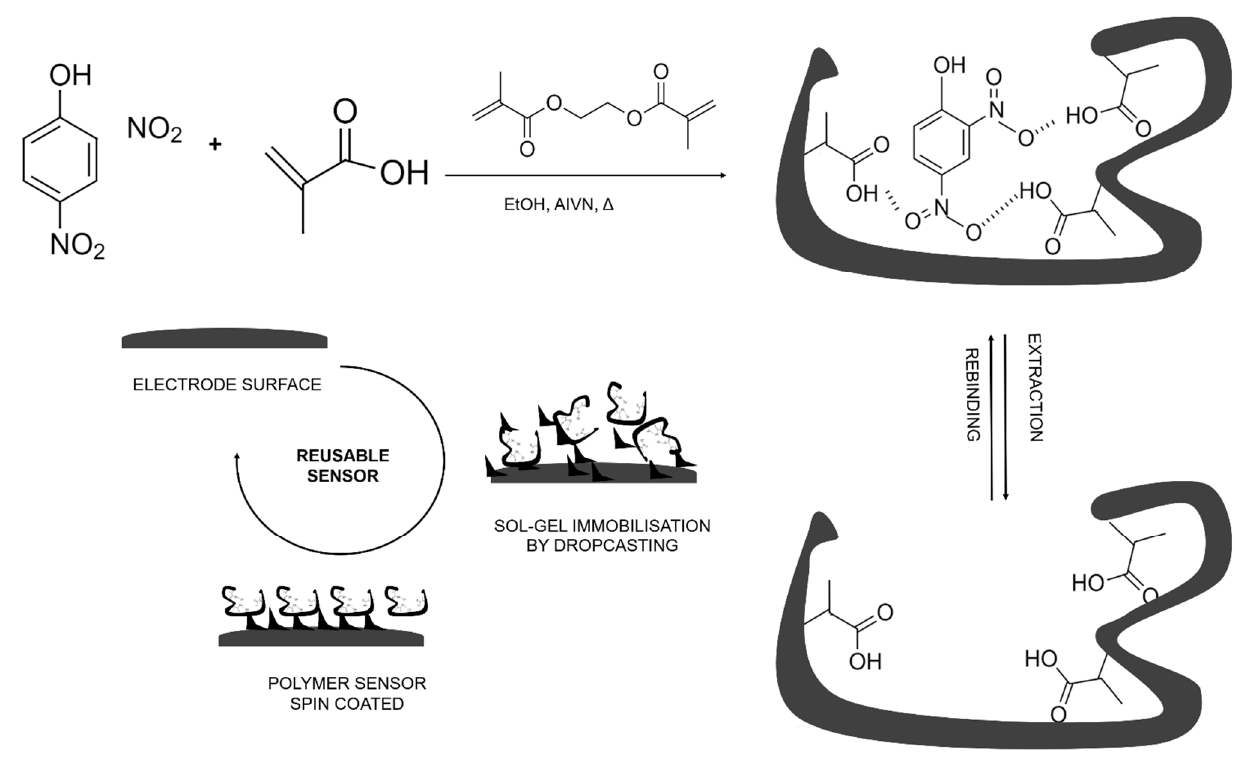
Figure 1. Schematic procedure of polymer imprinting synthesis process employing 2,4-dinitrophenol (DNP) and its immobilization onto the surface sensor.